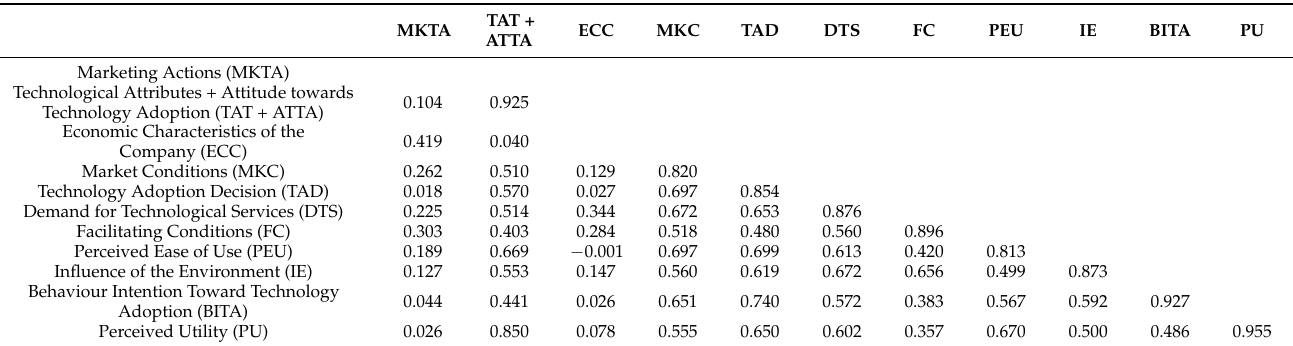
Table 3. Discriminant validity: Fornell-Larcker